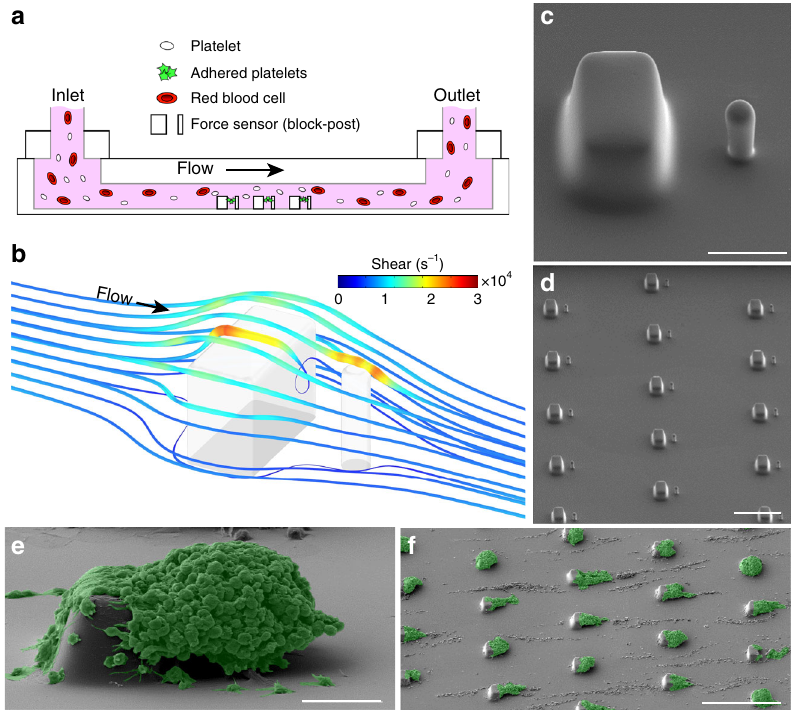
Fig. 1 Micro fl uidic formation of platelet aggregates. a Schematic of micro fl uidic device in which whole blood is injected at the inlet and platelets aggregate onto arrays of microscale blocks and fl exible posts for the measurement of platelet forces. b Computational fl uid dynamics simulation at a wall shear rate of 8000 s − 1 show local regions of high shear that platelets encounter as they follow the streamlines that transit over a block and post. c Scanning electron microscopy (SEM) micrograph of a block and post at the bottom of the microchannel. Scale bar, 10 μ m. d SEM micrograph of an array of blocks and posts. Scale bar, 50 μ m. Pseudo-colored SEM micrograph of platelet aggregates that formed on ( e ) a block and post (scale bar, 10 μ m) and f on an array of blocks and posts (scale bar, 100 μ m) after 70 s of blood fl ow in the